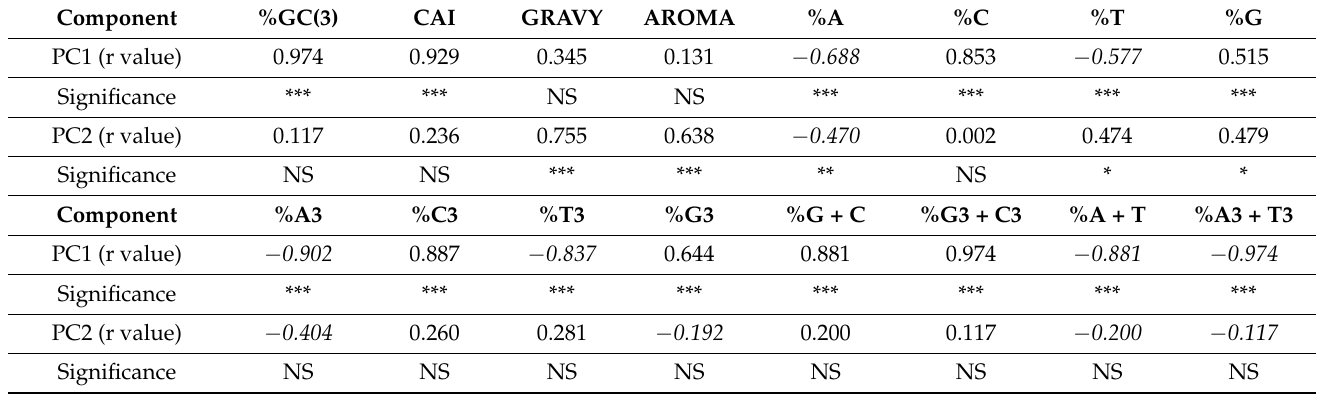
Table 3. Correlation analysis of PC1 and PC2 with compositional constraints, protein properties (GRAVY and AROMA), and gene expression.